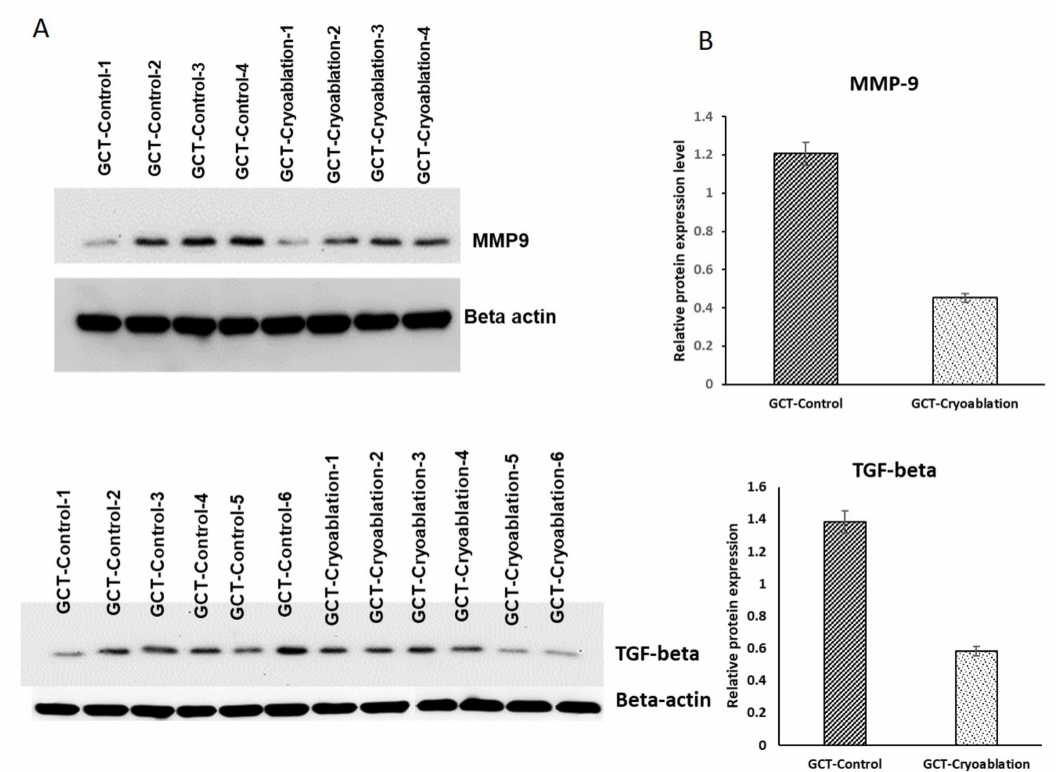
Figure 7. Validation analysis of the selected proteins from the giant cell tumor of bone profiling ( A ) MMP and TGF-beta immunoblot analysis. Both proteins increased expressions were identified in GCT-untreated / control showed reduced expressions after cryoablation treatment of GCT compared to GCT-untreated (GCT-control). ( B ) Bar charts representing the quantification data of overexpression’s of MMP9, TGF-beta were significantly expressed after cryoablation ( p -value < 0.01; one-tailed Student’s t -test). Error bars of the treated samples denote mean ±